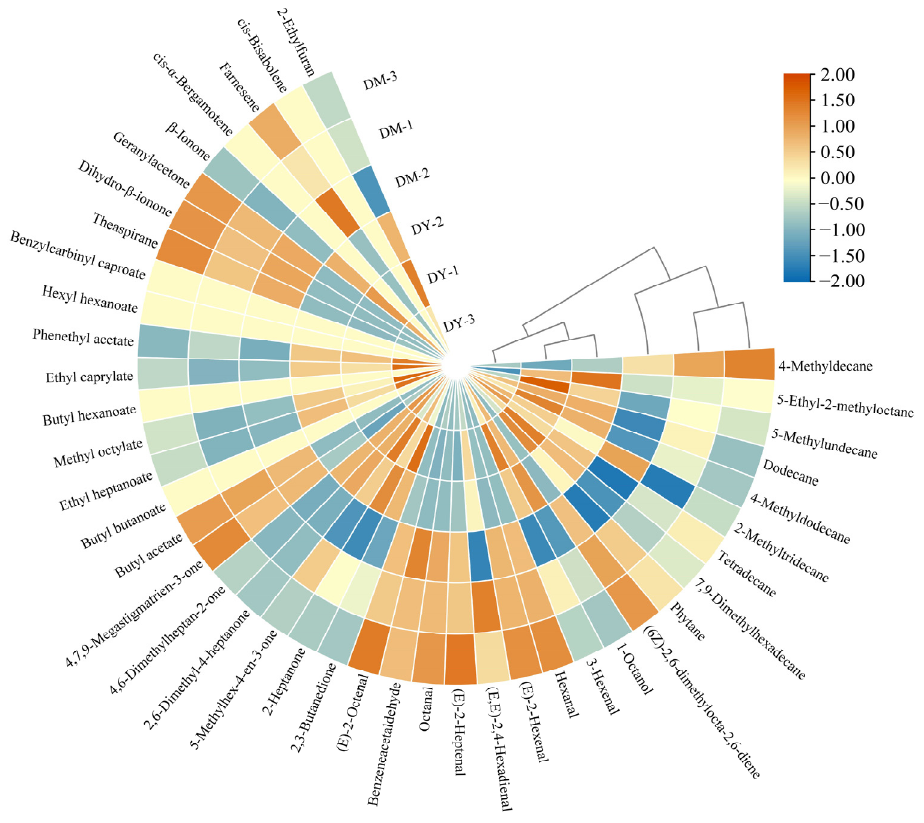
Figure 1. Heat maps of volatile compounds and their relative contents in D. delavayi fruit of varying maturities.